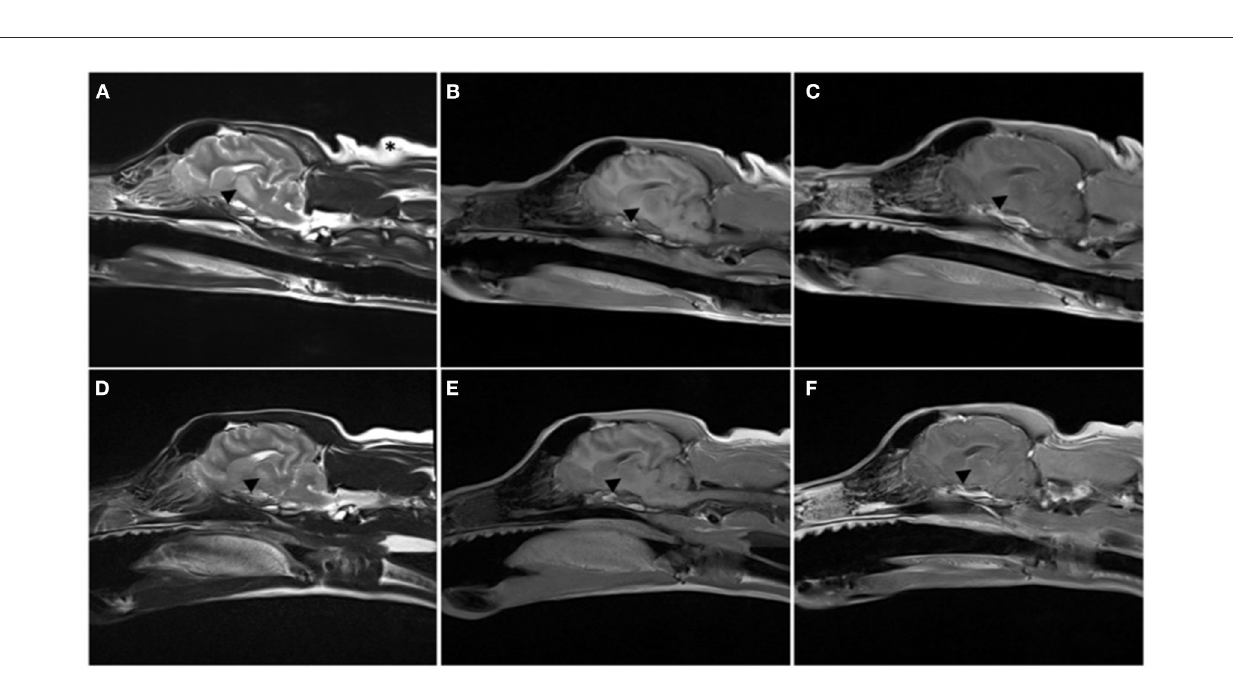
FIGURE2 Parasagittal MRI images performed on day 4 of hospitalization (A–C) and at recheck 130 days later (D–F) . T2-weighted (A, D) , T1-weighted pre- (B, E) , and post- (C, F) administration of intravenous gadolinium. Note the T2W hyperintense lesion extending from the thalamus to the midbrain [arrowhead in (A) ], T1 hypointense non contrast enhancing lesion is mostly present within the thalamus. The lesion was markedly reduced in size at follow-up MRI, only present in the thalamus, and with the same MRI